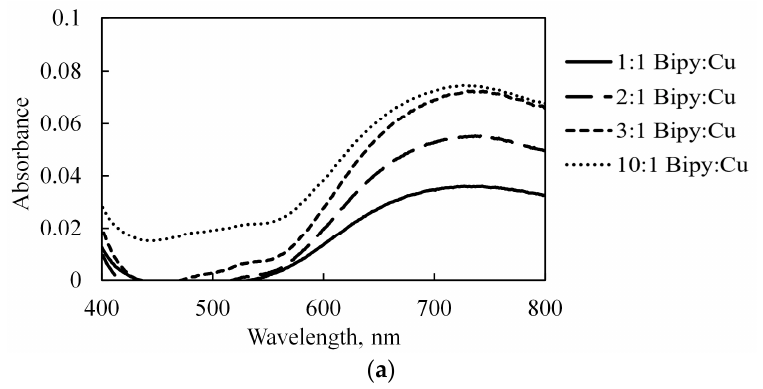
Figure 2. Absorption spectrum of 1% w/w Bipy in 90% w/w aqueous HAN compared to no addi-